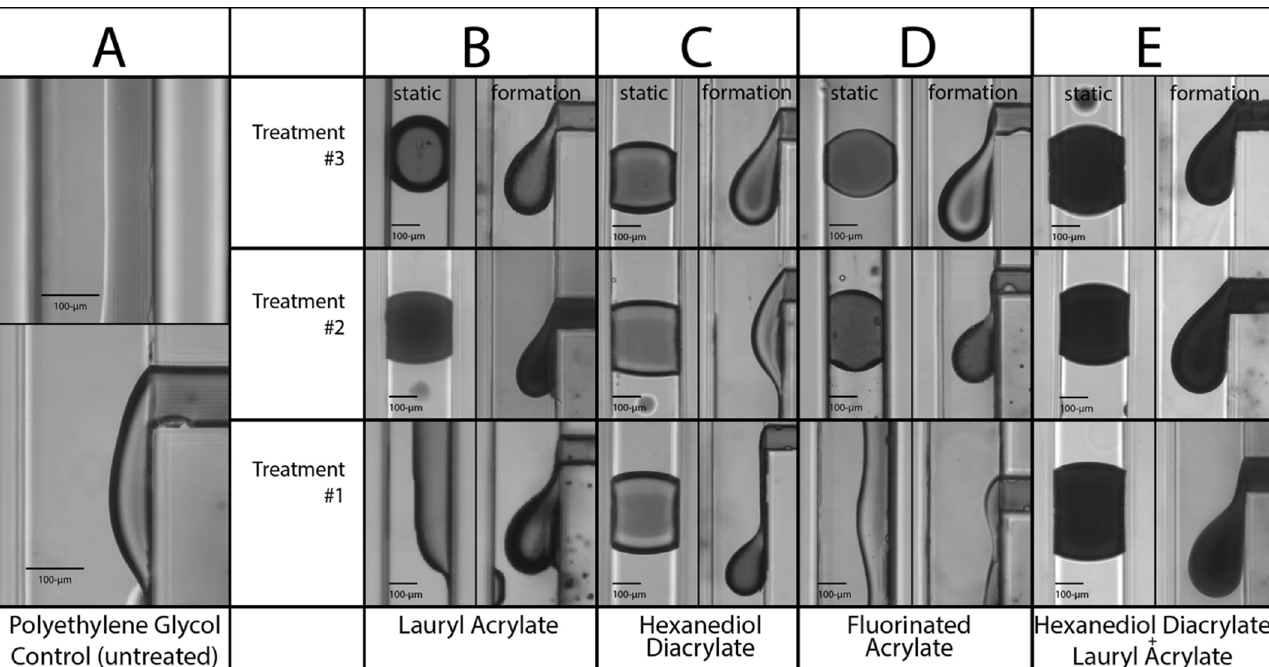
Figure 3. Droplet generation from T ‐ junction with various hydrophobic acrylate coatings; each treatment involved a coating of the acrylate monomer followed by a UV exposure and washing with IPA. Multiple treatments were used to increase the effectiveness of the coatings. Column ( A ): PEG ‐ diacrylate ‐ polymerized T ‐ junction (lower) and serpentine channel (upper) showing 2 ‐ phase flow and no droplets formation on untreated polymer. ( B ): Droplet formation on base ‐ polymer treated once (lower), twice (middle) or three times (upper) with lauryl acrylate. ( C ): Droplet formation on base ‐ polymer treated once (lower), twice (middle) or three times (upper) with hexanediol diacrylate. ( D ): Droplet formation on base ‐ polymer treated once (lower), twice (middle) or three times (upper) with fluorinated acrylate. ( E ): Droplet formation on base ‐ polymer treated once with hexanediol diacrylate and then treated once (lower), twice (middle) or three times (upper) with lauryl acrylate.